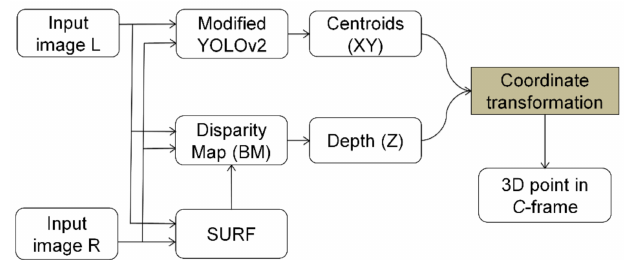
Figure 6. Flow diagram of the coordinate transformation.